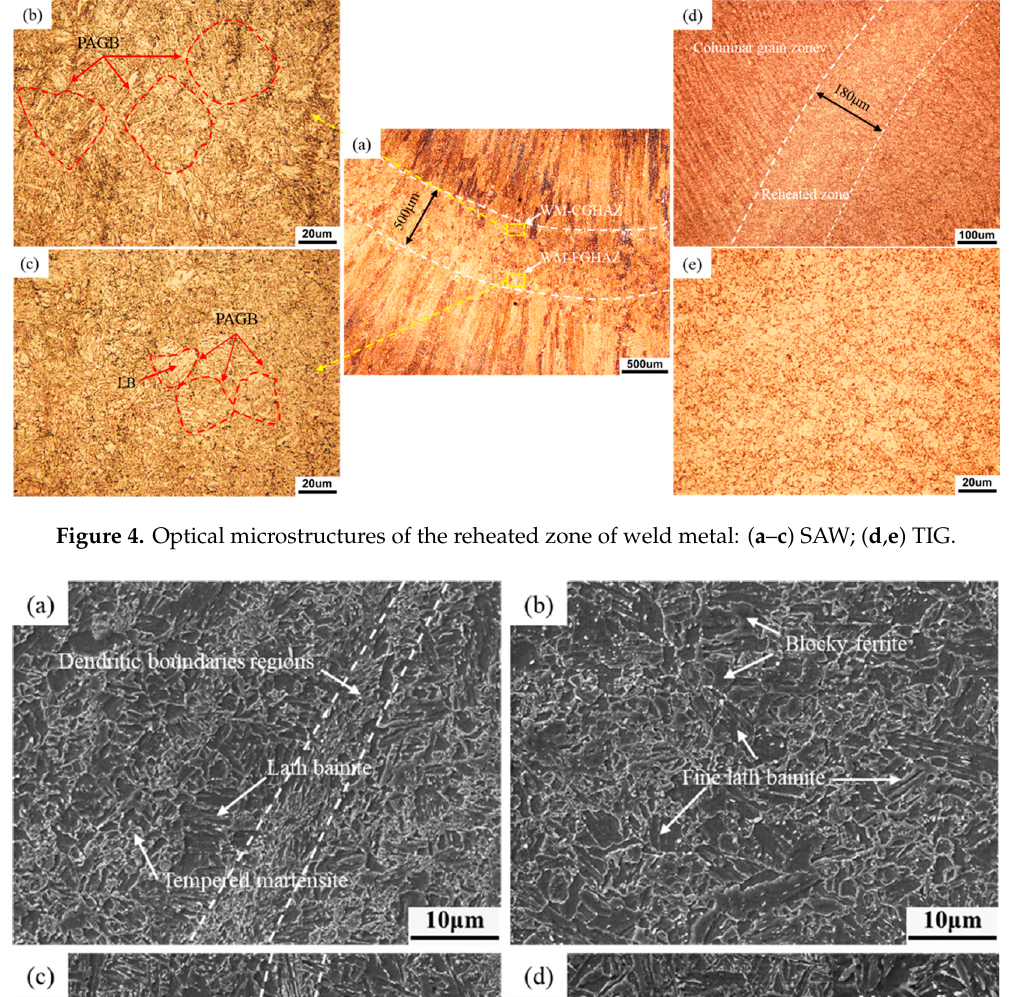
Figure 4. Optical microstructures of the reheated zone of weld metal: ( a–c ) SAW; ( d,e ) TIG.